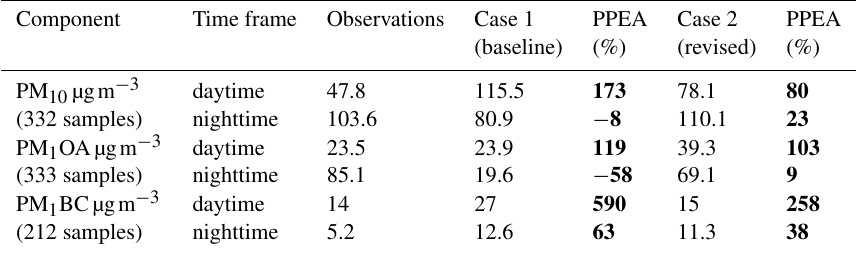
Table 4. Mean daytime and nighttime maximum values and prediction skill metrics of the aerosol concentrations against ground measure- ments (at Thissio) during the RWB smog period (19 December 2013–5 January 2014) in Athens. Numbers in bold represent the calculated statistics, given by Eq. (A3).